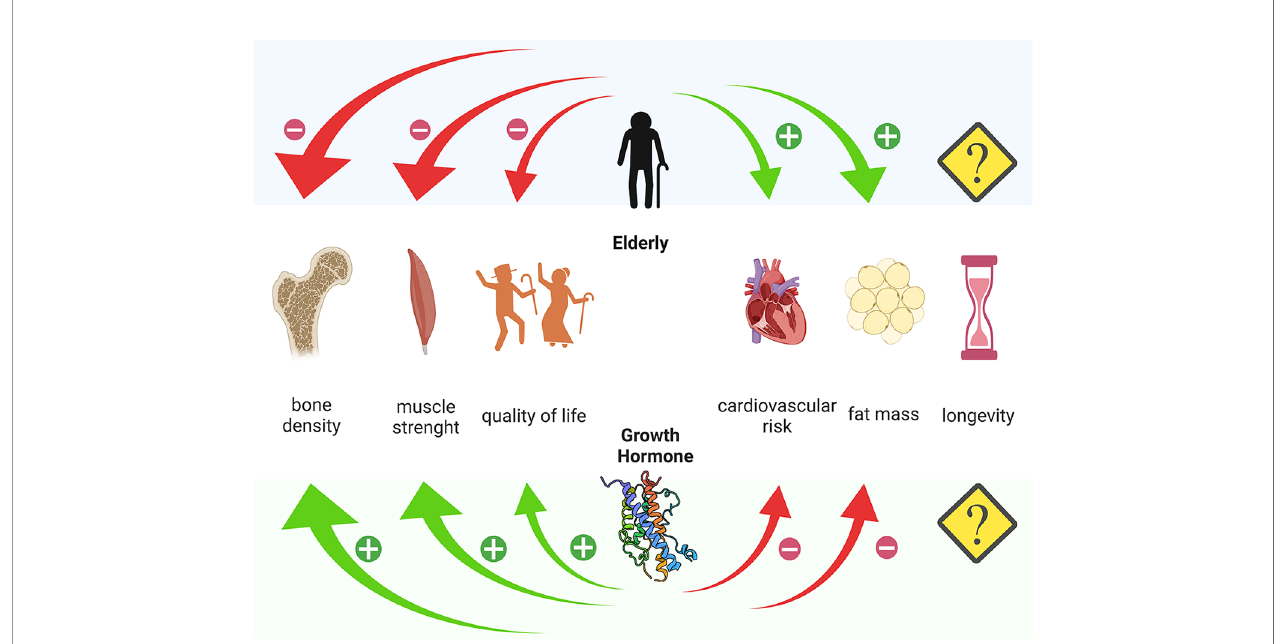
FIGURE 1 | Different action of age and Growth Hormone on bone density, muscle strength, quality of life, cardiovascular risk and fat mass. Created with